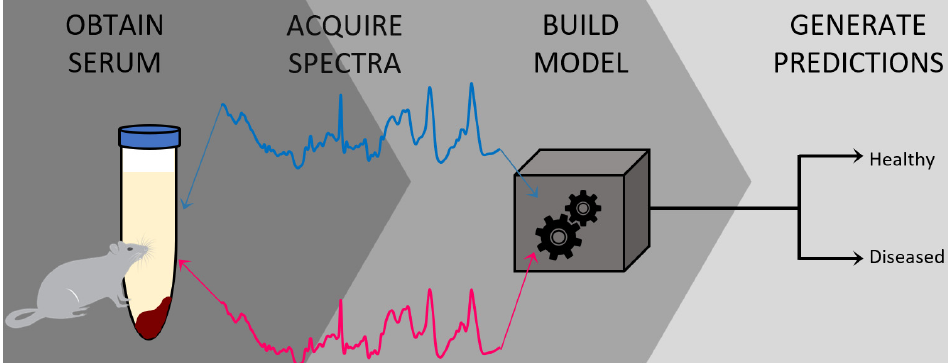
Figure 1. Graphical representation summarizing the protocol described herein, beginning with the collection of blood serum from the mouse donors and subsequent preparation of the serum for collecting Raman spectra. Then, the chemometric model is built and validated to be further used for generating classification predictions.